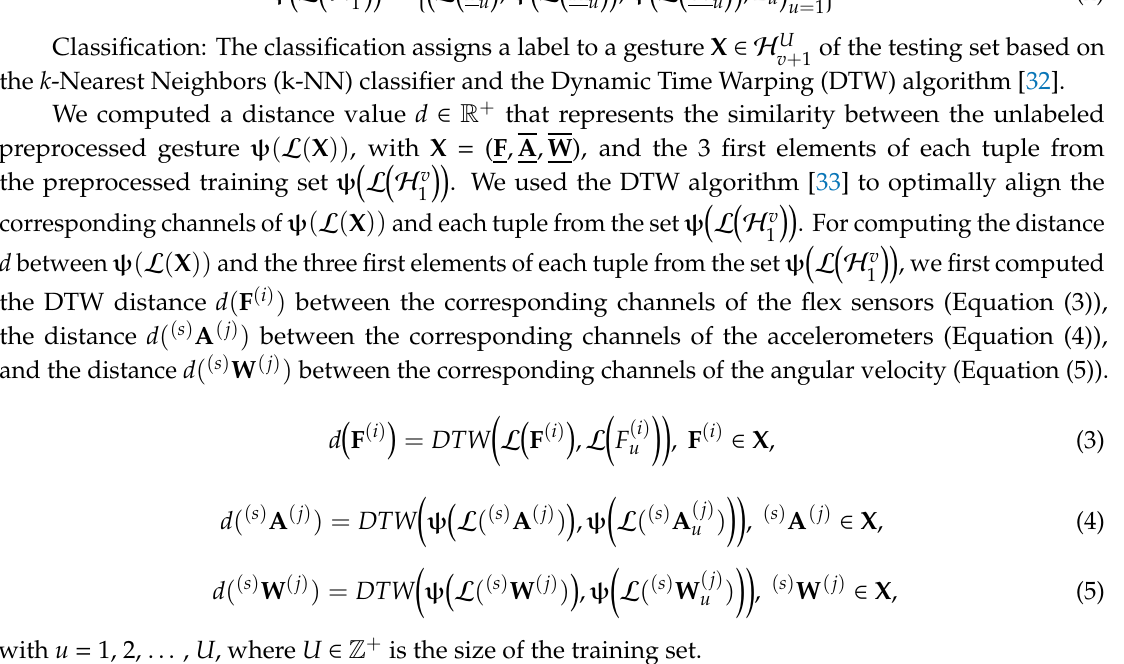
of the testing set based on v + 1